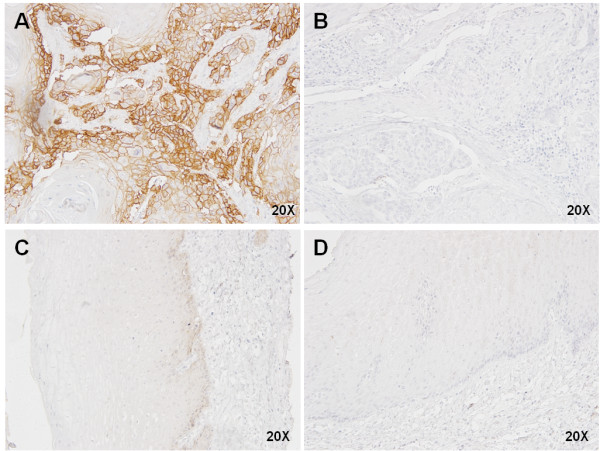
Expression of EGFR in ESCC by immunohistochemistry. (A) Representative figure of a EGFR positive staining case in ESCC, and (B) its corresponding negative control. (C) Representative figure of a EGFR negative case in ESCC, and (D) its corresponding negative control.